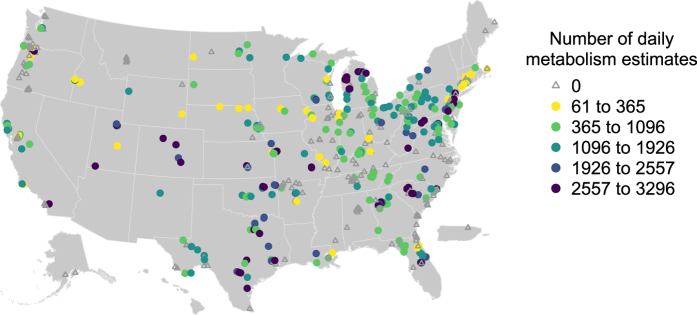
Sites included in this data publication.Sites that met the initial site selection criteria but did not have sufficient data to be modeled are gray triangles. Sites with sufficient data for modeling are filled circles, colored according to the number of dates for which estimates were produced (3296 days is 9.02 years).